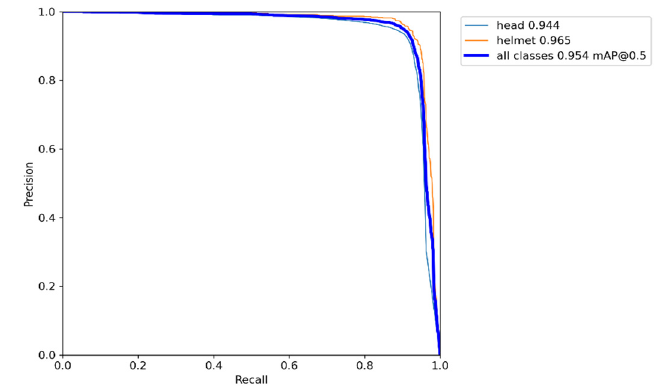
Figure 9. Precision and recall with focal-EIOU. Table 2. Comparison experiment of detector.